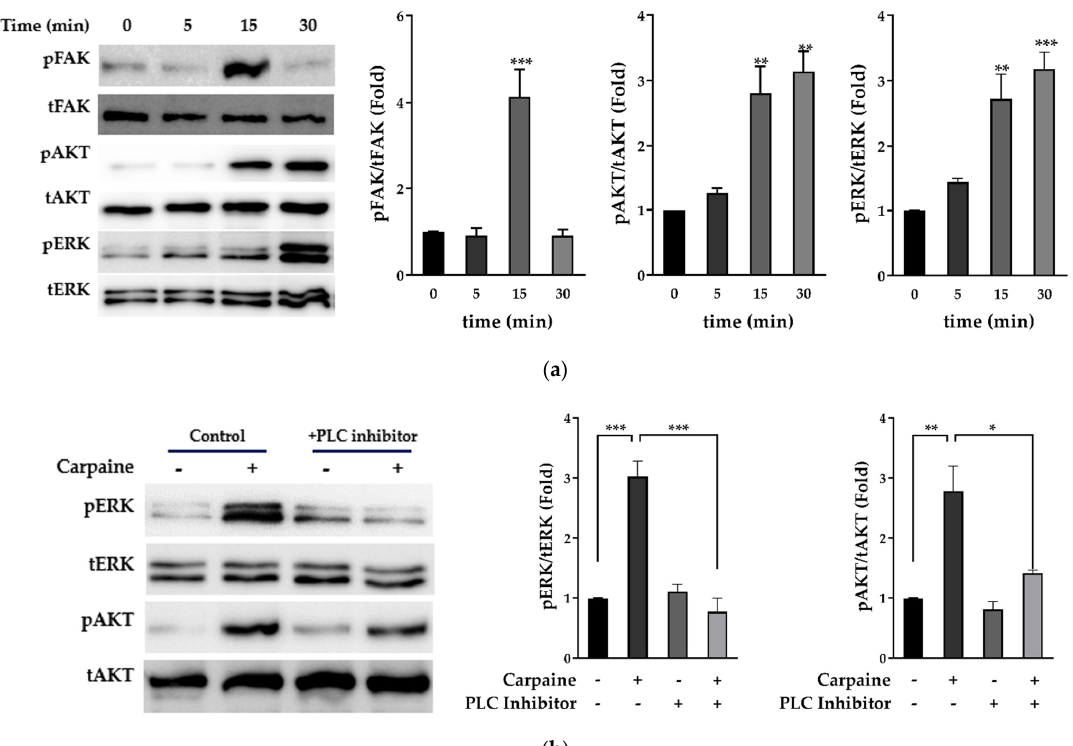
Figure 2. Carpaine triggers upstream FAK-induced ERK1/2 and AKT activation in H9c2 cells. ( a ) Carpaine treatment induces FAK, AKT, and ERK1/2 phosphorylation in H9c2 cells in a time- dependent manner. H9c2 treated with or without carpaine (1 µ M) for 0, 5, 15, and 30 min. Represen- tative Western blot images and the quantification of phosphorylated FAK (pFAK), phosphorylated AKT (pAKT), and phosphorylated ERK (pERK) levels, normalized to total FAK (tFAK), total AKT (tAKT), and total ERK (tERK), respectively. The protein band intensity is expressed as the fold change compared to the 0 min group. ( b ) Carpaine treatment mediates H9c2 proliferation via ERK1/2 and AKT activation. H9c2 cells were pre-treated with 1 µ M PLC inhibitor (U73122) for 20 min followed by treatment with or without carpaine (1 µ M) for 30 min. Representative Western blot images and the quantification of the pERK and pAKT levels, normalized to tERK and tAKT, respectively. The protein band intensity is expressed as the fold change compared to the non-treated control group. Quantitative data are shown as the means ± SEM ( n = 3). * p < 0.05, ** p < 0.01, *** p < 0.001, significantly different, as indicated by a two-way ANOVA with Tukey’s comparison